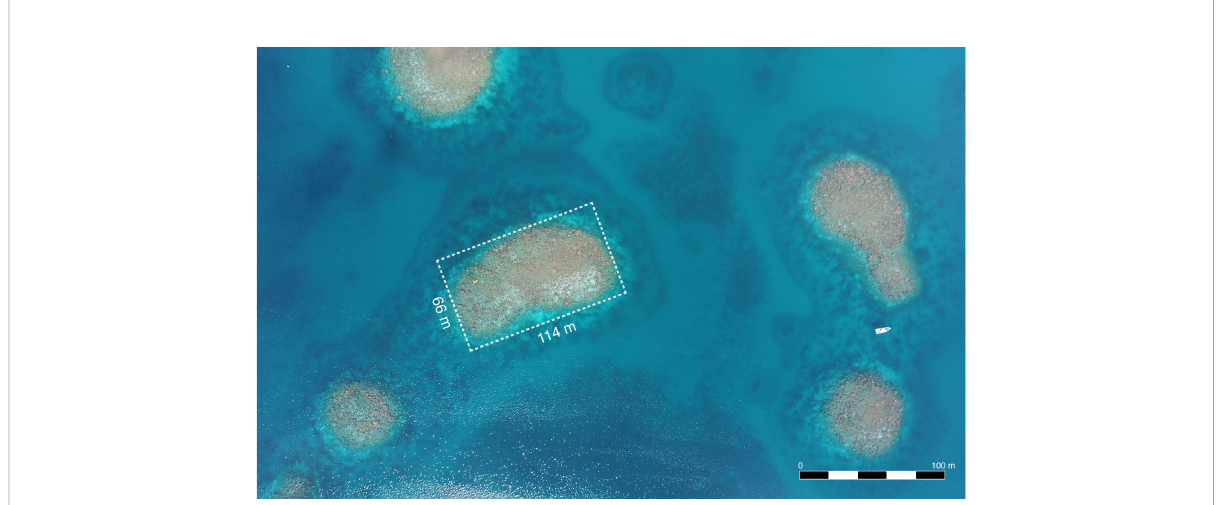
FIGURE 2 Aerial view of fl at-top patch reefs in the Dongsha Atoll lagoon. Brown areas are living coral and white areas are sand; all are submerged. The patch reefs are 114 m in length; the research vessel, Atoll 2 , in the right middle is 11 m in length, right middle is 11 m in